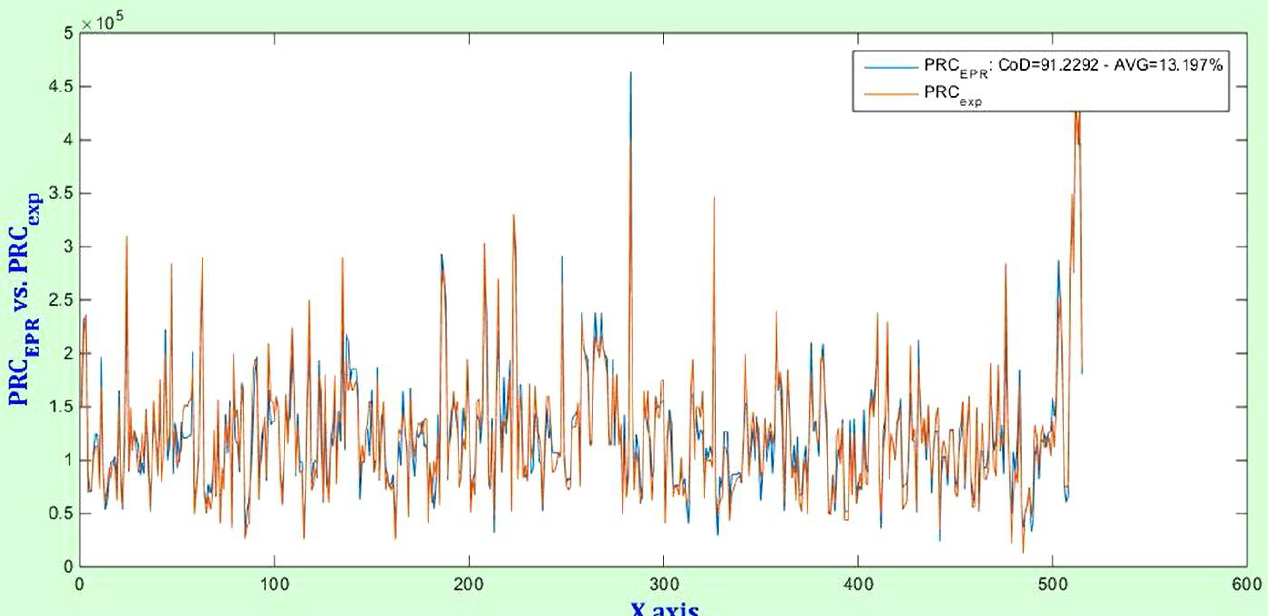
Figure 5. Selling price determined by EPR-MOGA (PRC EPR ) vs. selling price expected for model V (PRC exp ).